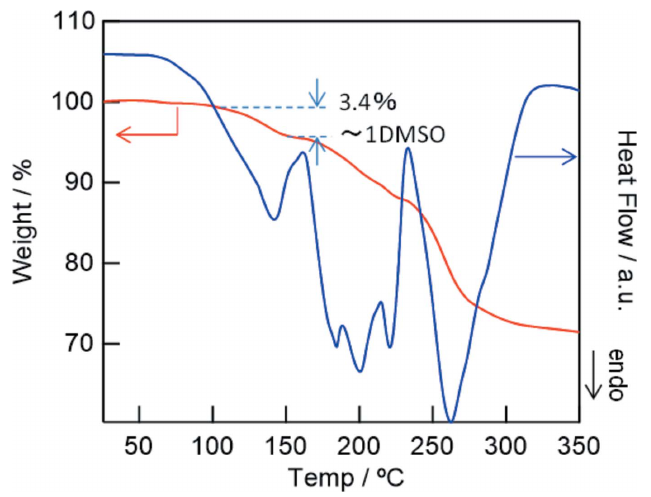
Figure 3 TG–DTA curves acquired under a nitrogen atmosphere.